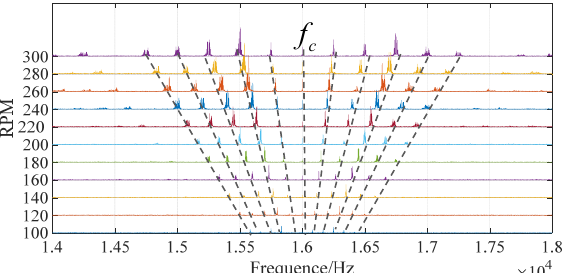
Figure 12. Testing result: the effects of chopping frequency on the waterfall.